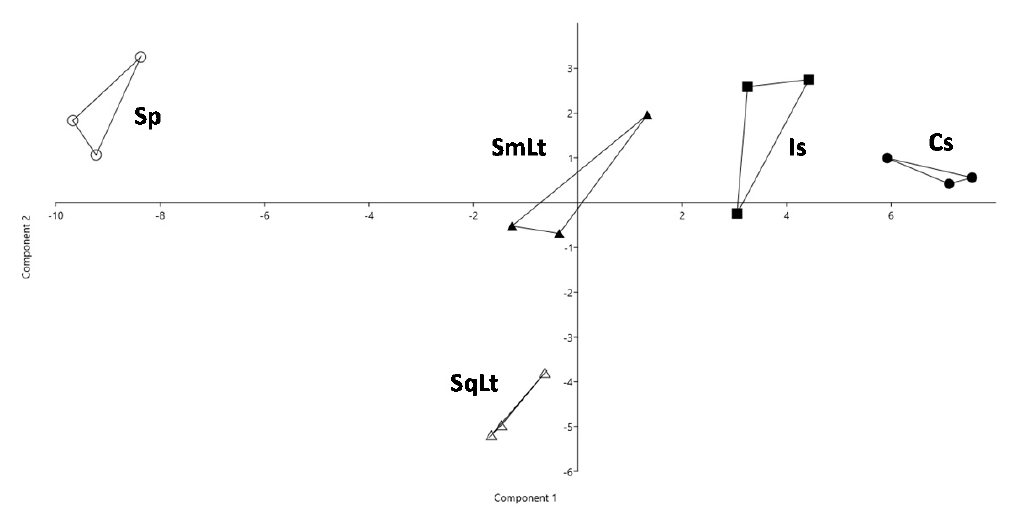
Figure 4. PCA of the chemical characteristics of wines produced from natural grape must. PC1